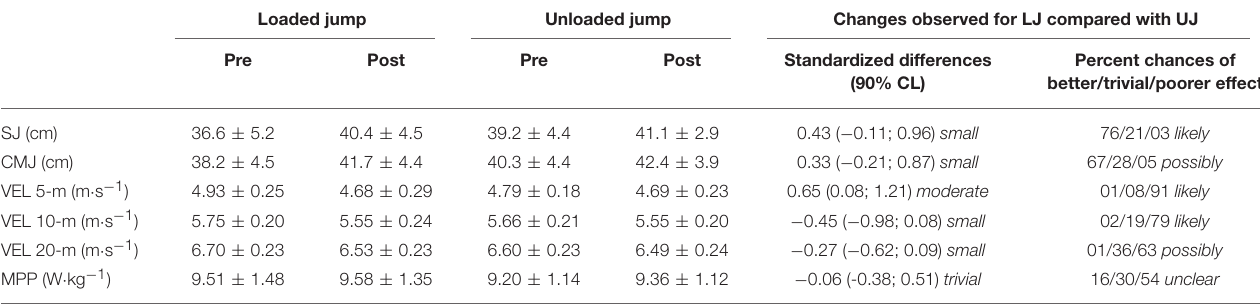
TABLE 3 | Comparisons of the changes observed for both groups of training in the performance tests after a 6-week preseason period in young soccer players. Loaded